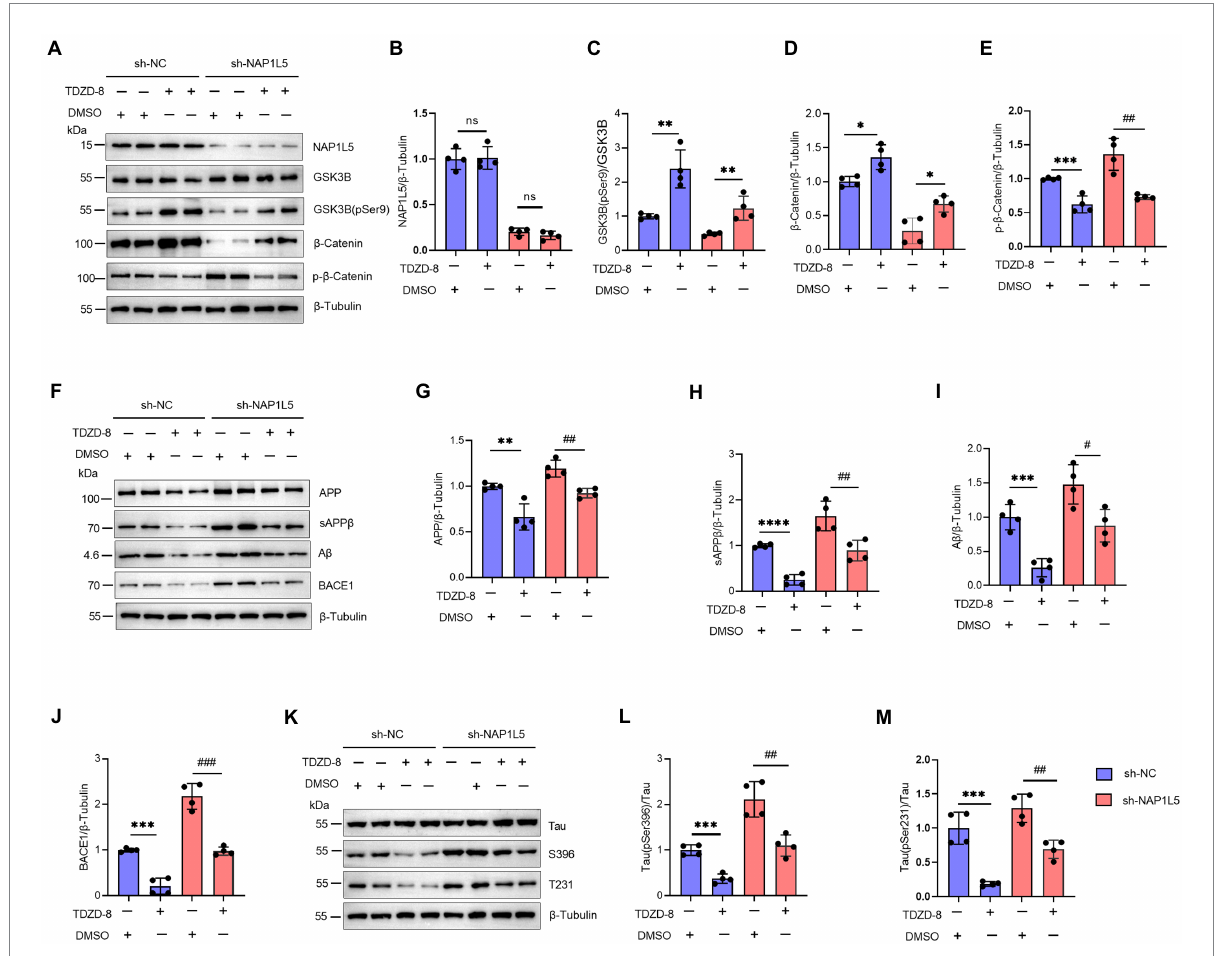
FIGURE 6 NAP1L5 regulated APP metabolism and Tau phosphorylation through the GSK3B/Wnt/ β -Catenin signaling pathway in N2a-APP695sw cells. (A–M) , N2a-APP695sw cells, stably transfected with sh-NC or sh-NAP1L5, were treated with DMSO or TDZD-8 (25 μ M) for 48 h. The NAP1L5, GSK3B, phosphorylated GSK3B at serine 9 [GSK3B (pSer9)], β -Catenin, and phosphorylated β -Catenin levels were measured using Western blotting (A) , and then quantified (B–E) . The APP metabolism-related protein levels were measured using Western blotting (F) , and then quantified (G–J) . The Tau and phosphorylated Tau protein levels were measured using Western blotting (K) , and then quantified (L,M) . Data are presented as mean ± SD, n = 4. ∗ p < 0.05; ∗∗ p < 0.01; ∗∗∗ p < 0.001; ∗∗∗∗ p < 0.0001 for TDZD-8 (25 μ M) versus DMSO in N2a-APP695sw cells transfected with sh-NC. # p < 0.05; ## p < 0.01; ### p < 0.001; #### p < 0.0001 for TDZD-8 (25 μ M) versus DMSO in N2a-APP695sw cells transfected with sh-NAP1L5. ns, not significant; the Student’s t -test was